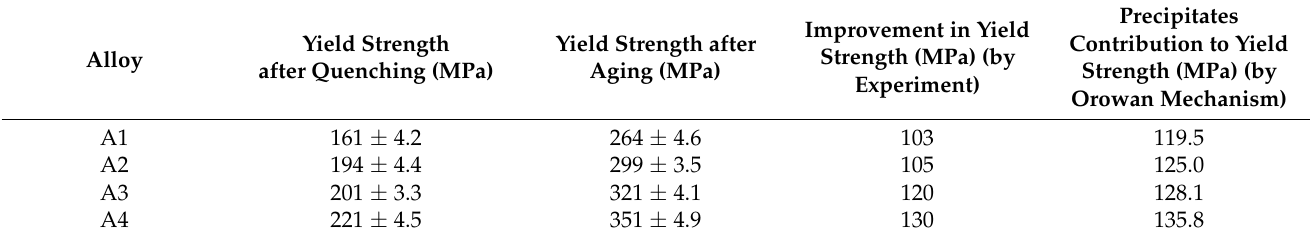
Table 4. Differences in the yield strength of the samples between quenching and aging and the contribution to yield strength from precipitates calculated by the Orowan